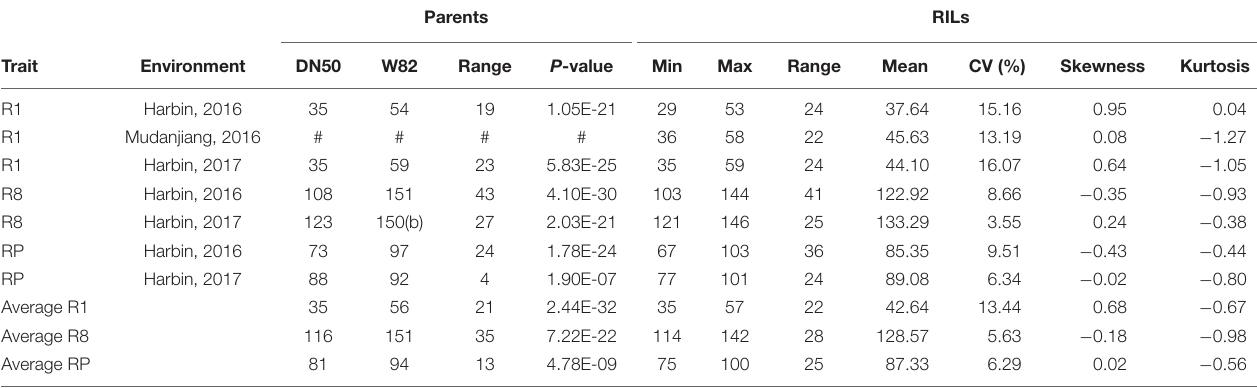
TABLE 2 | Statistical analysis result of the parents and the whole DW population.